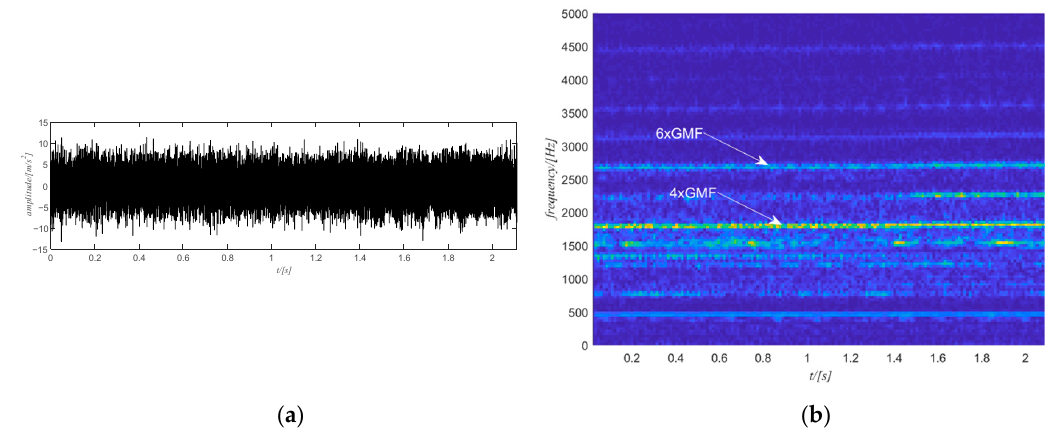
Figure 15. ( a ) The raw signal of case study 1; ( b ) the STFT of the raw signal.